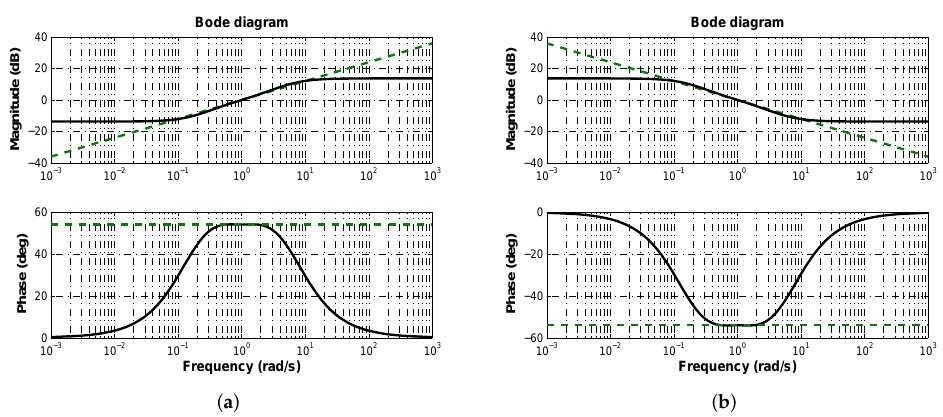
Figure 4. Frequency response of fractional-order approximation (3) for s ± 0.6 where dashed lines represent the theoretical response and solid lines the approximation. ( a ) Derivative effect. ( b ) Inte- gral effect.